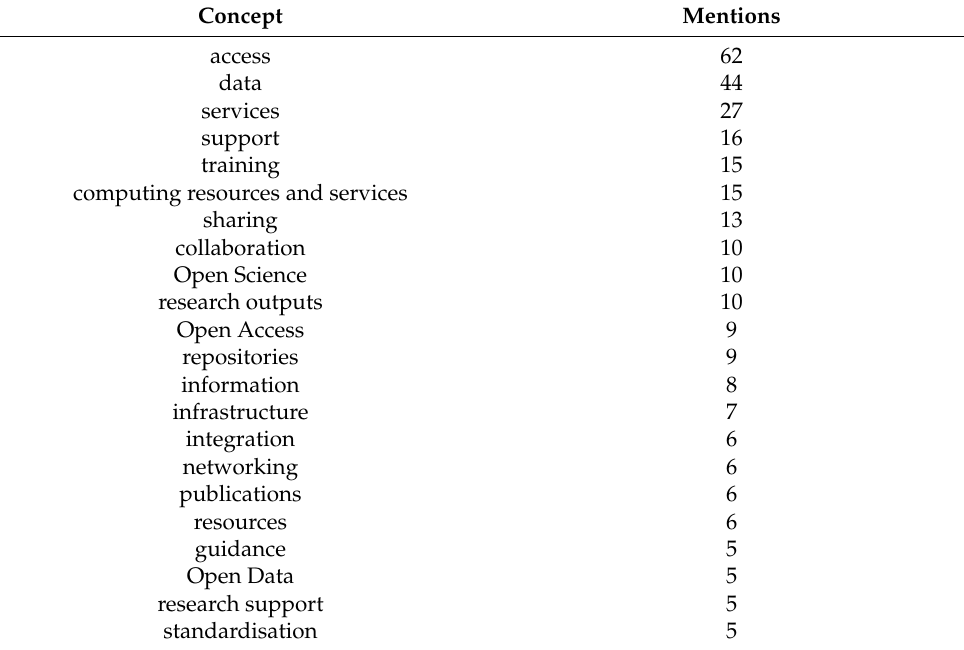
Table 2. Researchers’ expectations from EOSC: survey